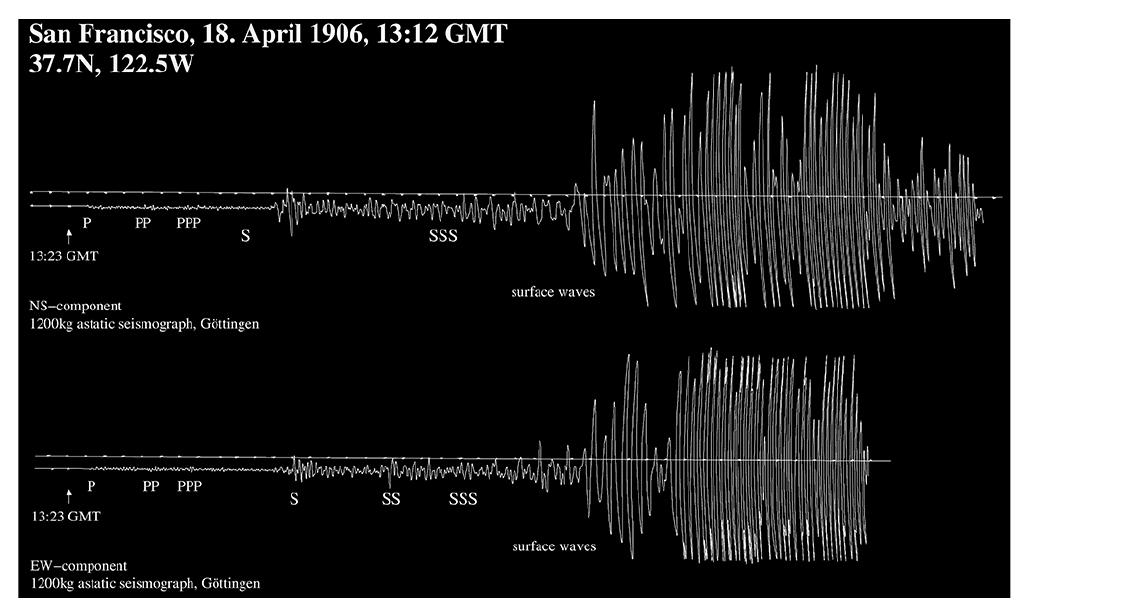
Figure 7. The record of the Great 1906 San Francisco earthquake with the astatic horizontal seismograph. Figure prepared and kindly provided by Elmar Rothert and Joachim